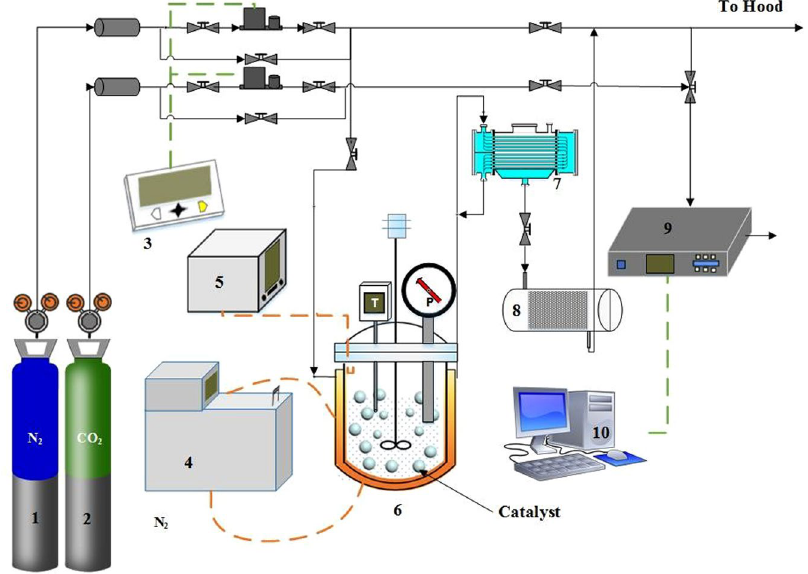
Figure 1. Schematic diagram of CO 2 desorption set-up [1: N 2 cylinder; 2: CO 2 cylinder; 3: mass flow controller; 4: thermostatic water bath; 5: thermoelectric couple; 6: stirred tank reactor; 7; condenser; 8: desiccator; 9; gas concentration analyzer; 10: data recording